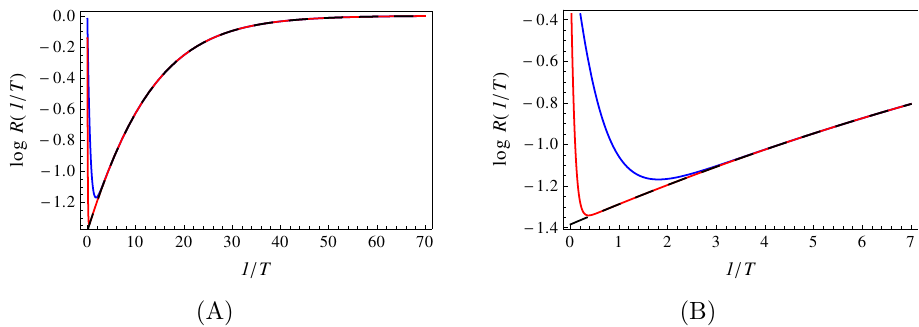
Figure 5. The thermal dependence factor of log C ∞ for weak perturbative chaotic systems, given by Z (2 β ) /Z ( β ) with β = 1 /T the inverse temperature, here given for a 2D linear harmonic oscillator with the frequencies ω x = ω y = 0 . 1 , with N = 20 levels (blue) and with N = 150 levels (red). We also plot the sum over N = ∞ levels (black). In (A) we zoom in at high β /low temperatures, and in (B) we focus on smaller β /larger T . The N = 150 plot is aready quite close to the monotonic N = ∞ dependence but at high temperatures there is always a region decaying with β , before the approximately linear log R (1 /T ) dependence sets in, just like in the numerical results. At very low temperatures the ratio saturates, as we see in the panel (A). This ensures that our estimate for the saturated OTOC has a finite limite at zero temperature. The overall scale is arbitrary as the R factor is always multiplied by various other